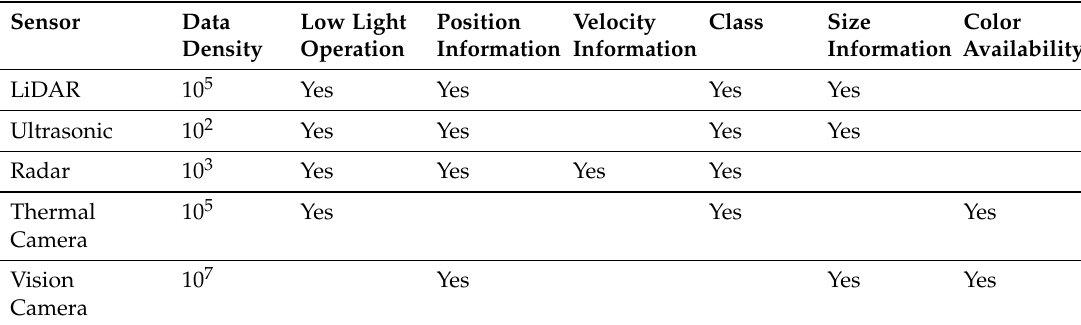
Table 2. Characteristics and properties of acoustic and vision based